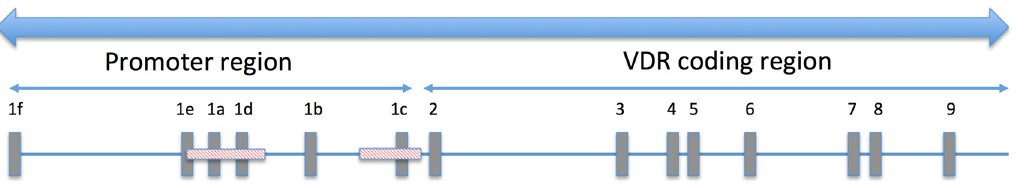
Figure 1. Schematic representation of hVDR (human Vitamin D Receptor) gene locus. The human VDR gene consists of 14 exons, six of which are different variants of exon 1, participating in the process of alternative splicing. Exons 2–9 are common to all known VDR protein isoforms. Regions in red indicate the area of two previously described putative promoter regions [10,11].